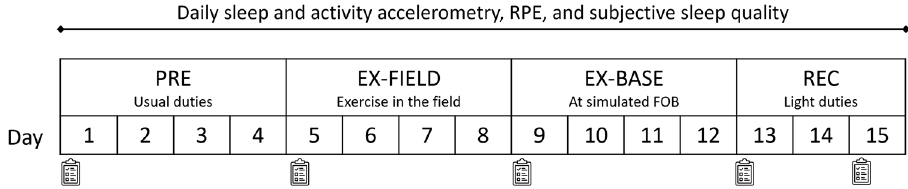
Figure 1. Overview of Study design. Note: clipboard icon indicates completion of MTDS upon awakening.